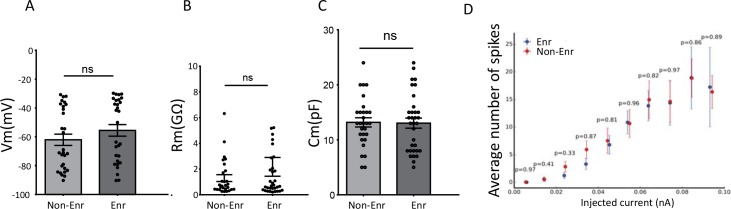
The biophysical properties of adult-born neurons.Implicit learning did not modify (A) the resting membrane potential (Mann-Whitney: Non-Enr vs Enr p=0.2). (B) the membrane resistance (Mann-Whitney: Non-Enr vs Enr p=0.76) or (C) the membrane capacitance of adult-born neurons (Mann-Whitney: Non-Enr vs Enr p=0.91) (Non-enriched: Non-Enr; Enriched: Enr). (D) The input-output curves of adult-born cells produced by 500 ms steps of injected currents at different intensities were not modified by implicit learning (Non-Enr n = 22 and Enr n = 19; Mann-Whitney test). Only neurons that were not silent were considered. The data are expressed as mean values ± SEM.